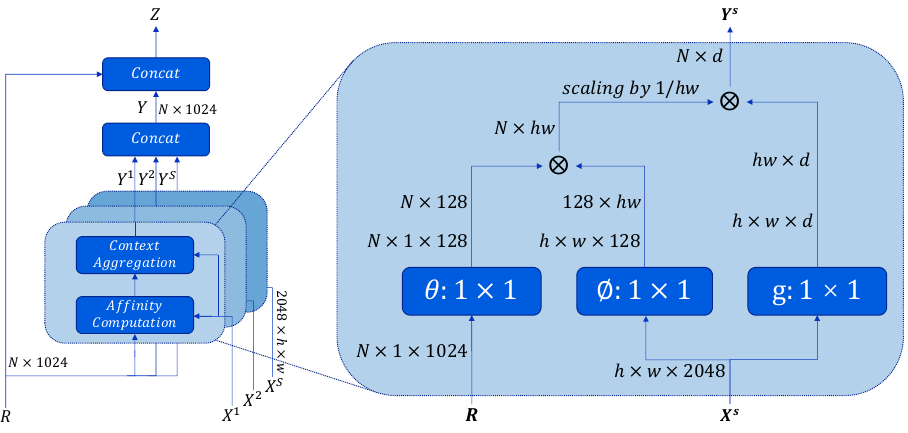
Figure 4. The pipeline of multiple Context Dependency Modules